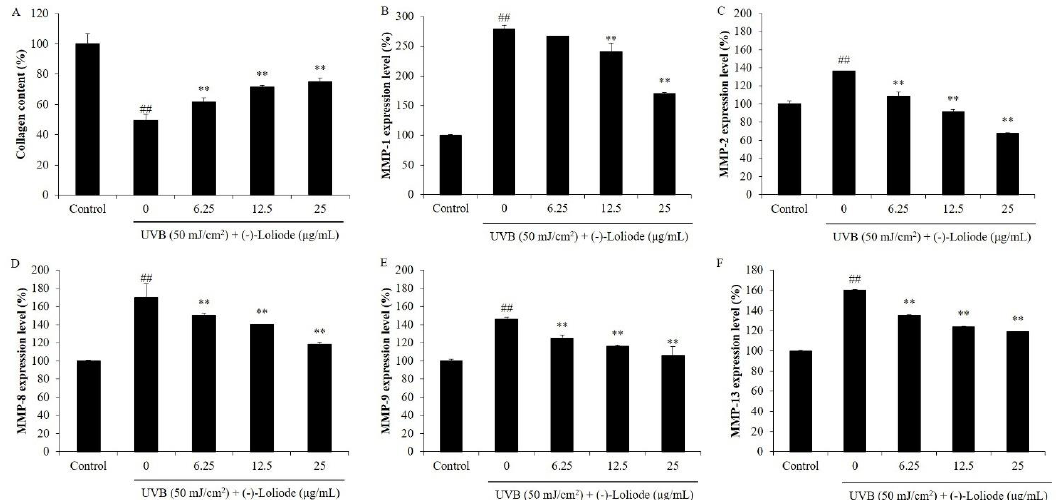
Figure 5. (-)-Loliode improves collagen content and inhibits the expression of MMPs in UVB-irradiated HDF cells. ( A ) Collagen contents in UVB-irradiated HDF cells; ( B ) MMP-1 expression levels in UVB-irradiated HDF cells; ( C ) MMP-2 expression levels in UVB-irradiated HDF cells; ( D ) MMP-8 expression levels in UVB-irradiated HDF cells; ( E ) MMP-9 expression levels in UVB-irradiated HDF cells; ( F ) MMP-13 expression levels in UVB-irradiated HDF cells. The amounts of collagen and MMPs were assessed using the ELISA kits following the manufacturer’s instructions. The data was expressed as the mean ± SE (n = 3). ** p < 0.01 as compared to the UVB-irradiated group and ## p < 0.01 as compared to the control group.